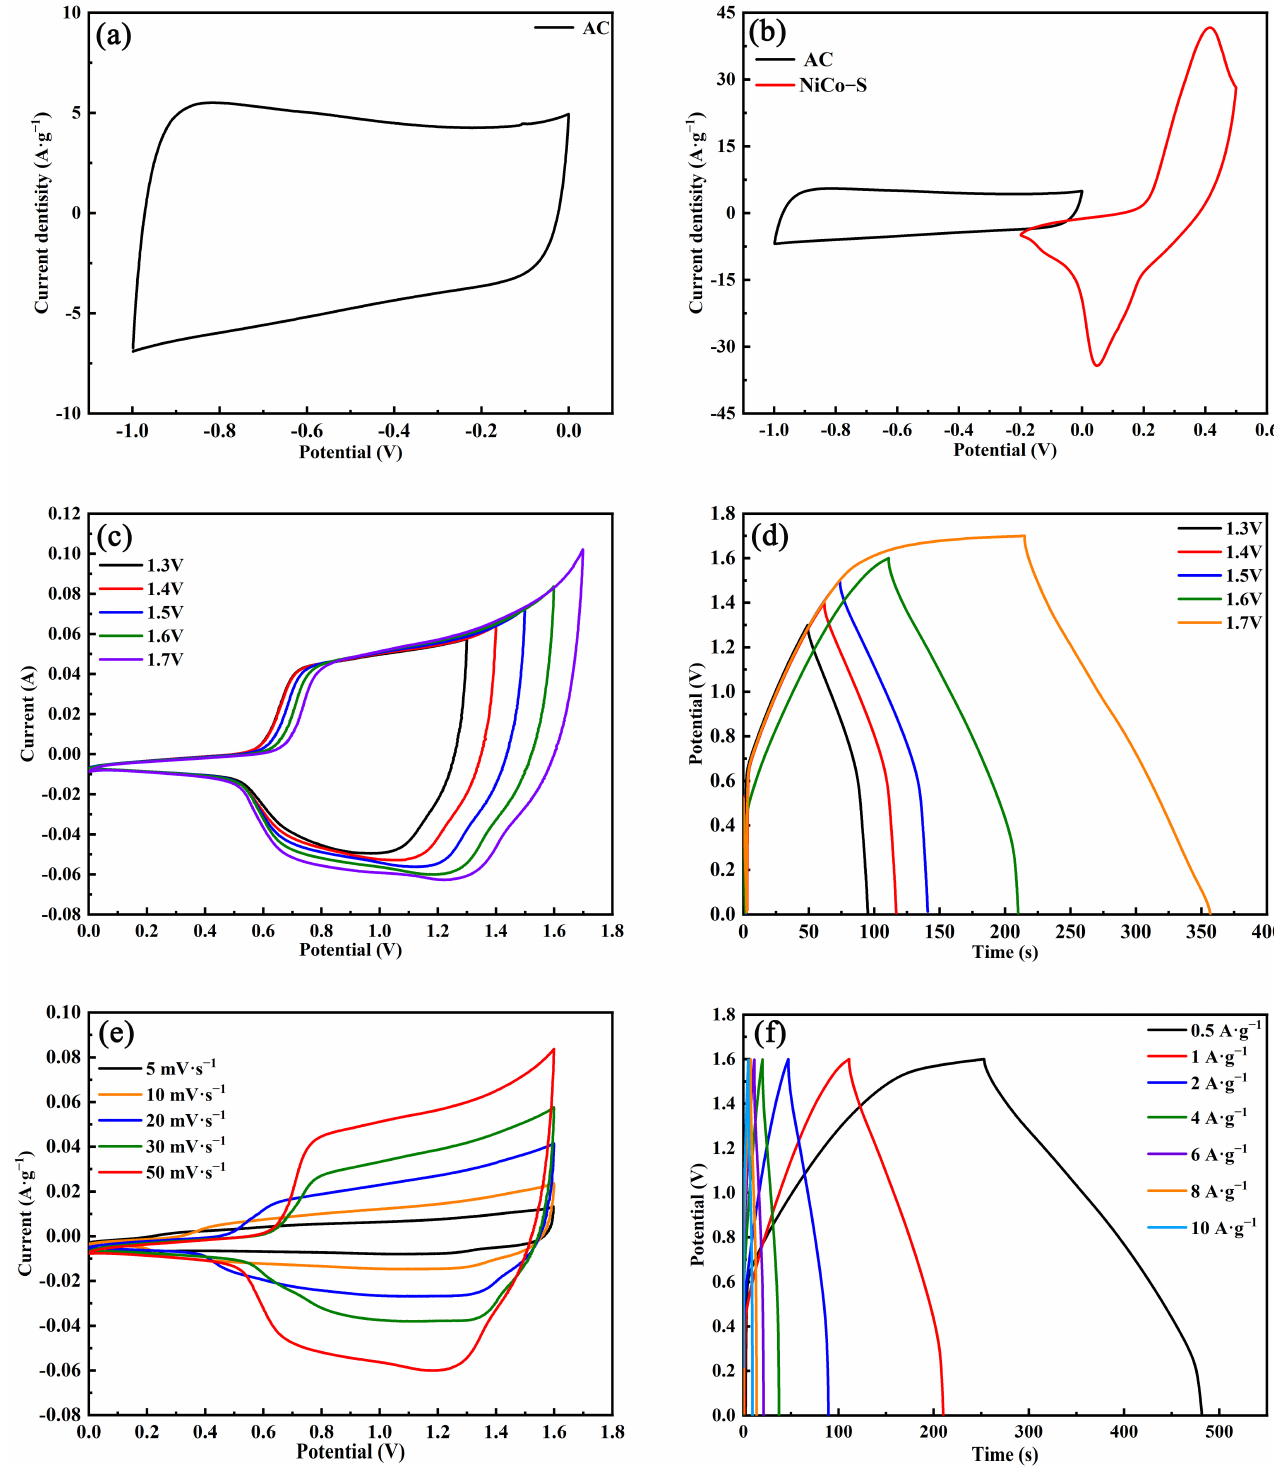
Figure 10. ( a ) CV curves of AC in a three-electrode system at a scan rate of 50 mV·s − 1 . ( b ) CV curves of NiCo-S and AC electrodes at a scan rate of 50 mV·s − 1 . ( c ) CV curves of HSC device at 50 mV·s − 1 with di ff erent potential windows. ( d ) GCD curves of HSC device at 1 A·g − 1 with di ff erent potential windows. ( e ) CV curves of HSC devices with various scan rates. ( f ) GCD curves of HSC device at di ff erent current densities.